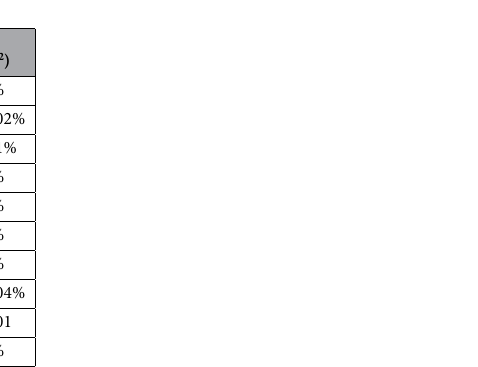
Table 2. Polarization parameters of the Blank and Ce-DDTC samples after 120 h.